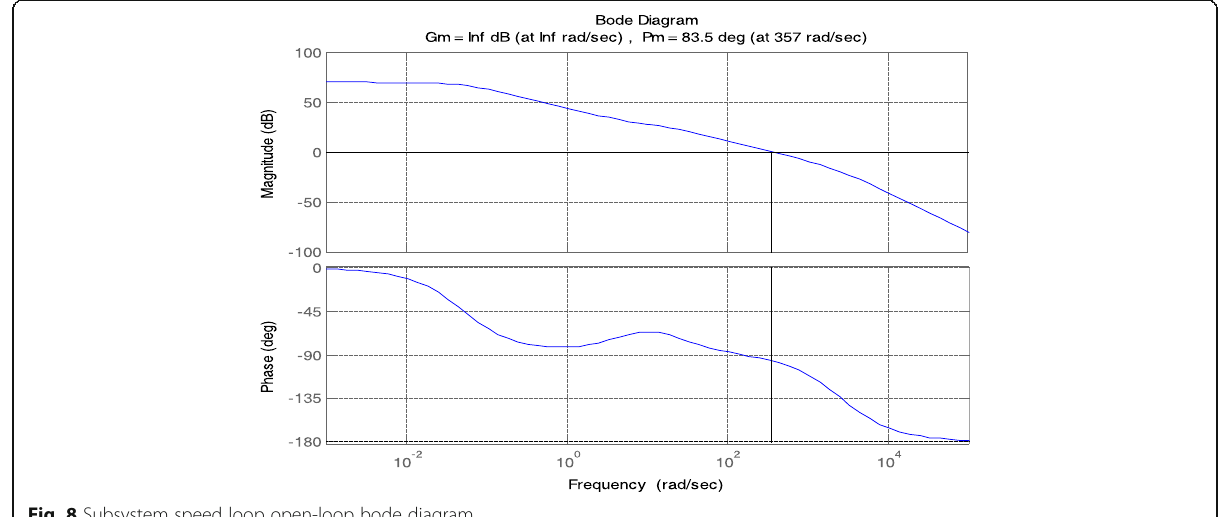
Fig. 8 Subsystem speed loop open-loop bode